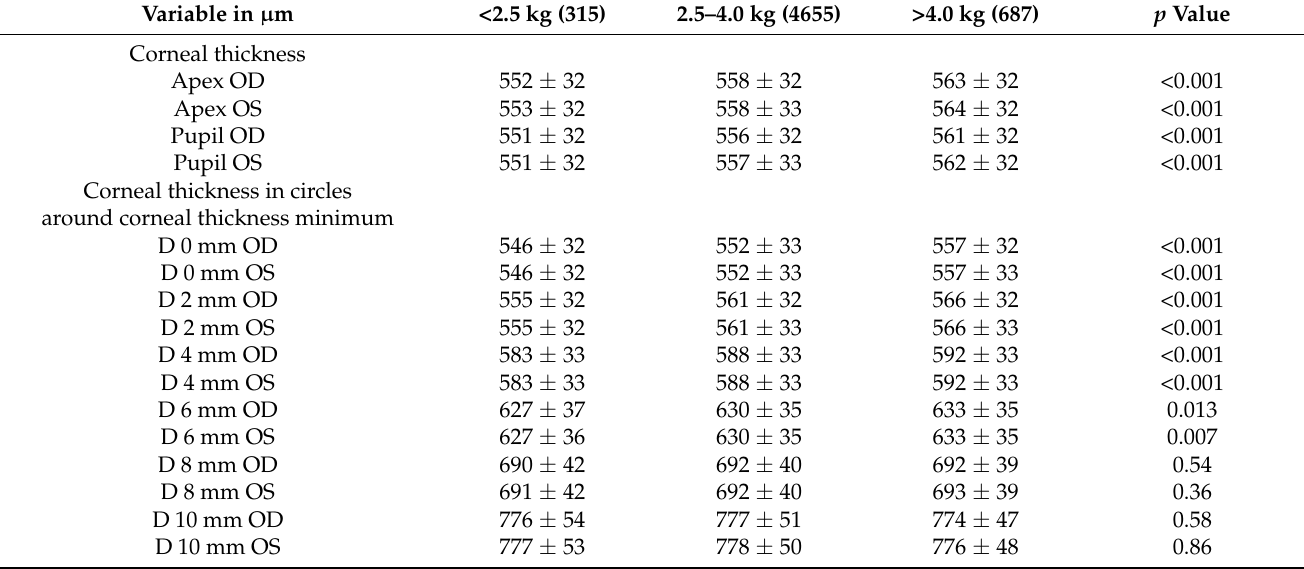
Table 2. Measurements of corneal thickness in different corneal areas stratified by birth weight groups with Scheimpflug tomography. Data from the population-based Gutenberg Health Study (2012-17). Mean ± Standard Deviation or Median and 25%/75% Quantiles.